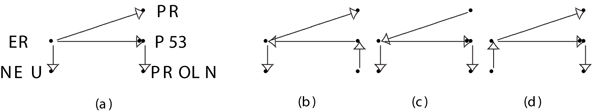
MultiDAG with AGE = High. Equivalence class of structures within patients with AGE equal to High. Node labels are shown only in DAG (a).